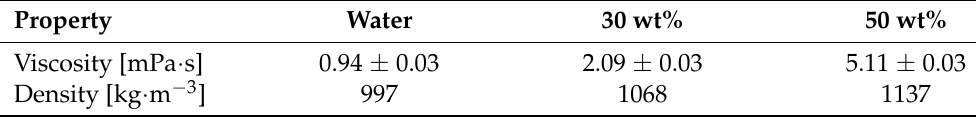
Table 1. Density and dynamic viscosity coefficient of the tested liquids at a temperature of 25 ◦ C.